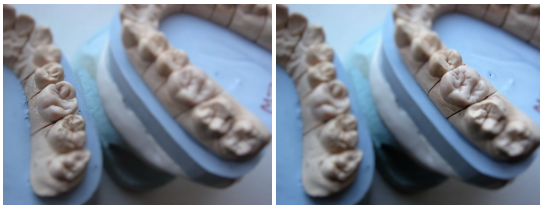
Figure 3. Modelled crowns on stone casts, ivory